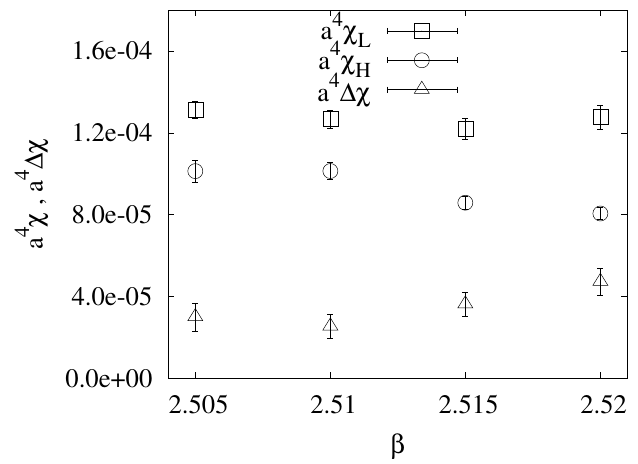
Figure 12 . The difference of a 4 χ in high and low temperature phases and their